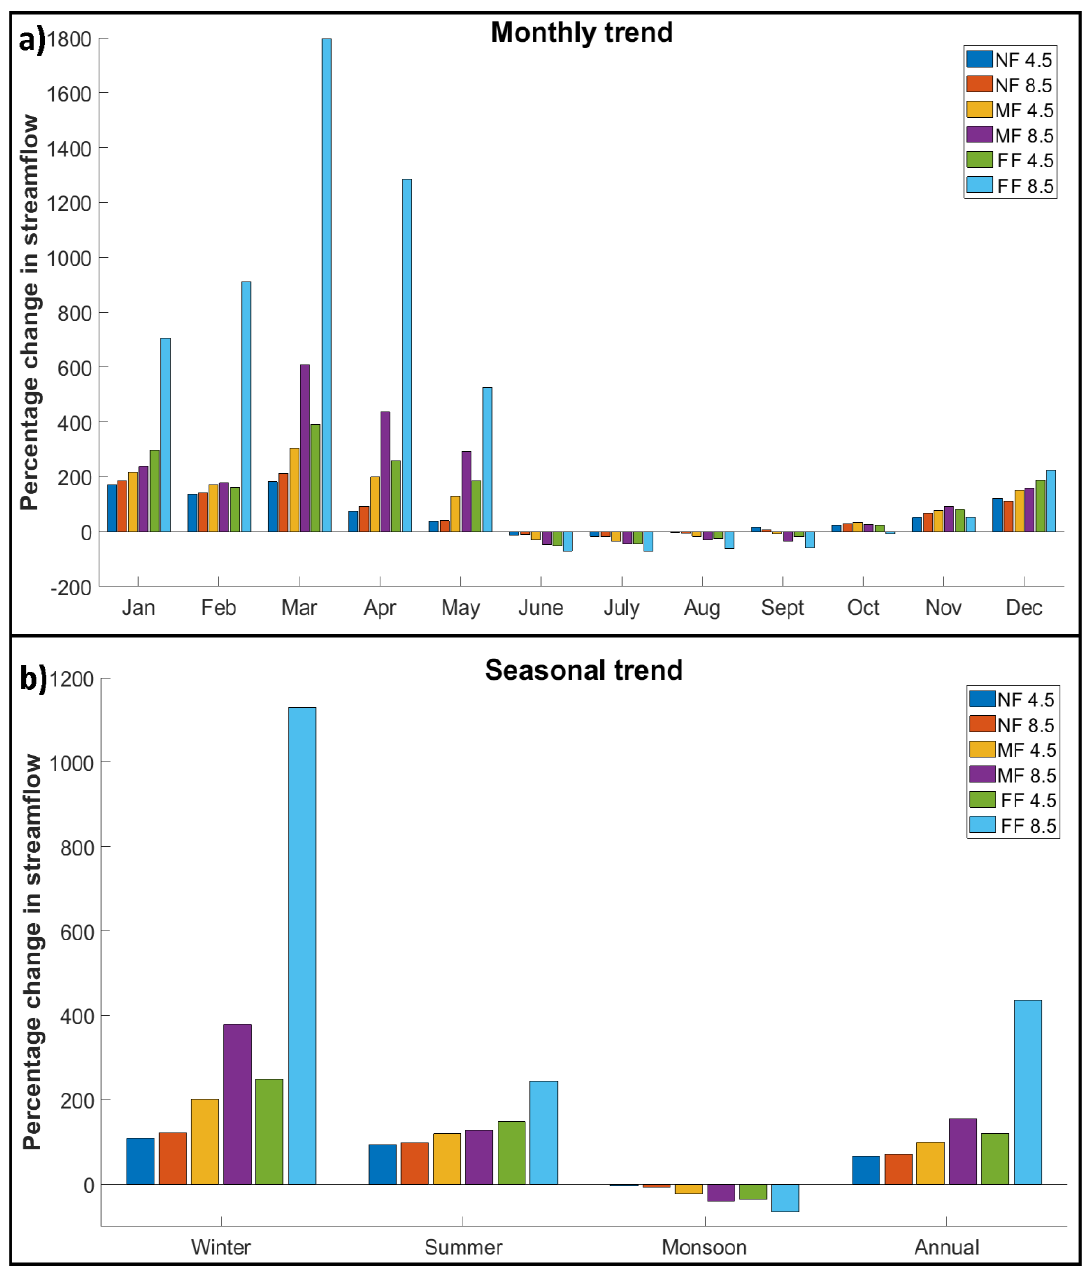
Figure 15. Changes in streamflow for the future time periods, relative to the baseline period. ( a ) Changes in mean monthly streamflow, ( b ) Changes in mean seasonal and annual streamflow in the BRB .